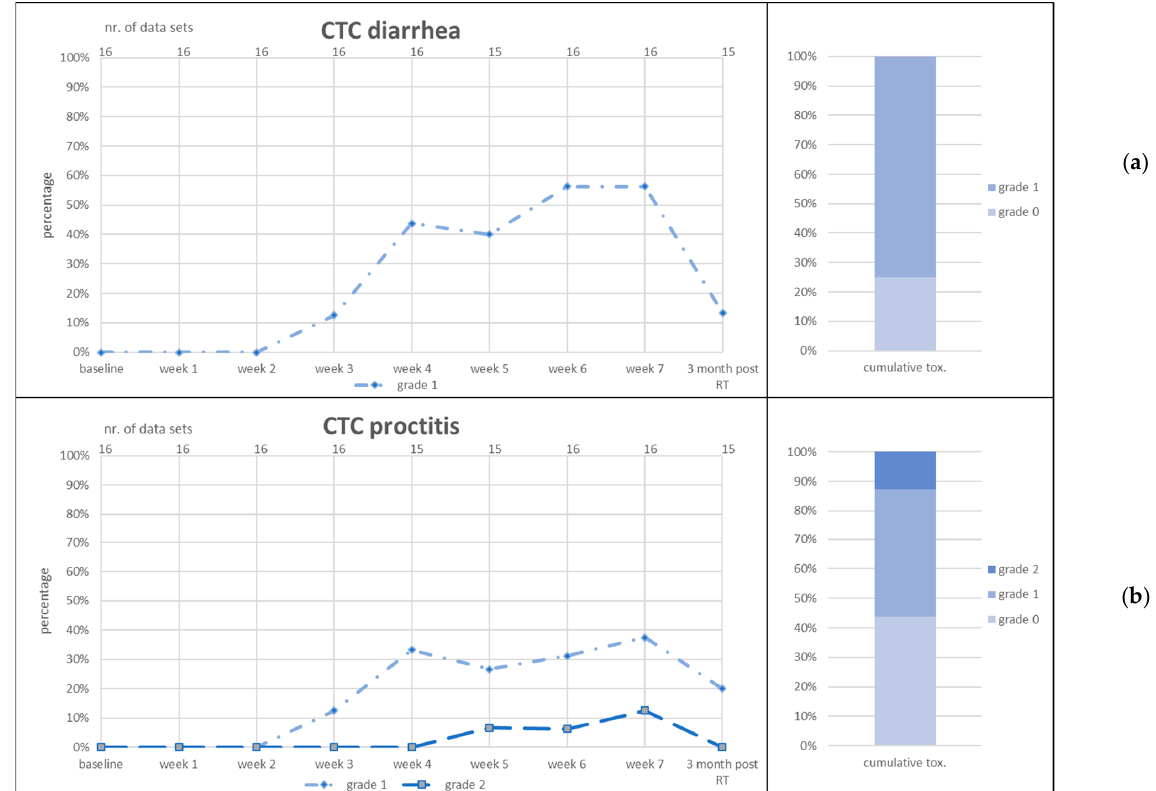
Figure 3. Acute gastrointestinal (GI) toxicity scored as CTC diarrhea ( a ) and CTC proctitis ( b ). RT = radiotherapy. Left graphs: number of patients in percent ( y -axis) who reported the toxicity item at the given point of time (lower x -axis). Number of data sets in upper x -axis. Right graphs: cumulative toxicity of the given item up to three months post RT.